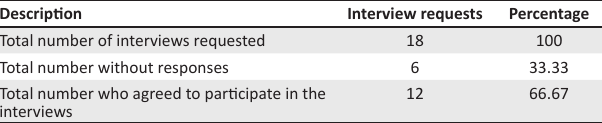
TABLE 1: Interview discussion request rate